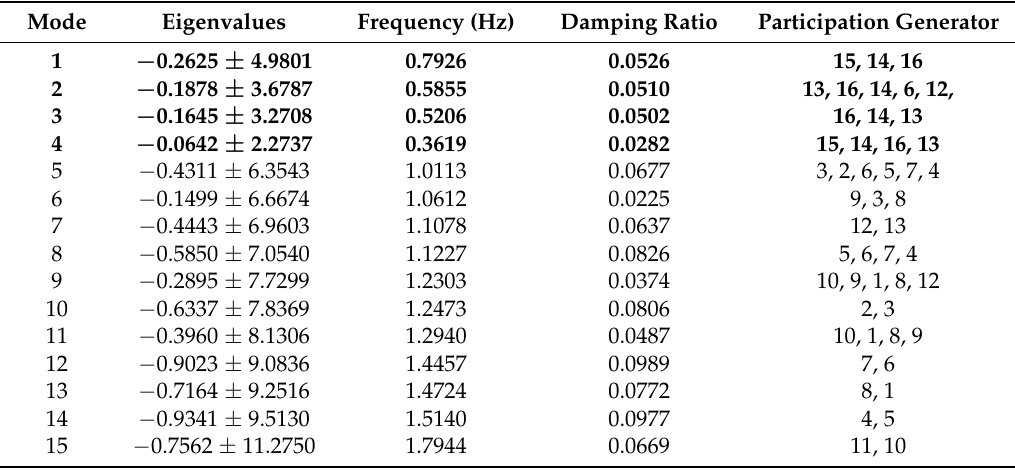
Table 1. Eigenvalues of 16-machine 68-bus original system.